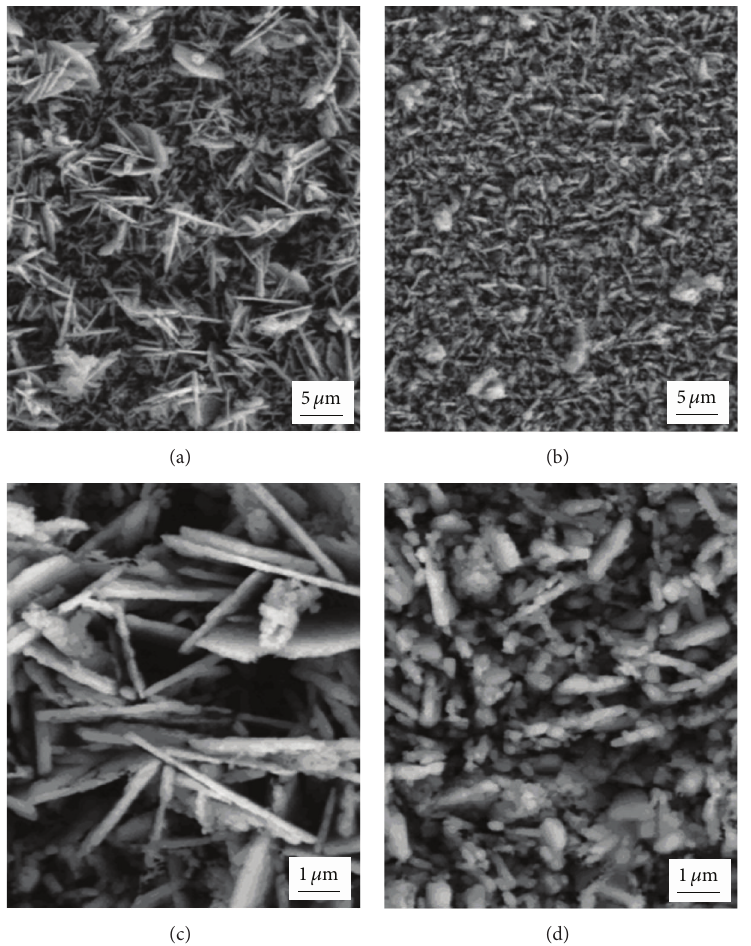
Figure 2: SEM images of TiCl 4 pretreatment used on FTO or not. (a) TiCl 4 pretreatment. (b) Without TiCl 4 pretreatment. (c) and (d) The amplification figure of (a) and (b), respectively.